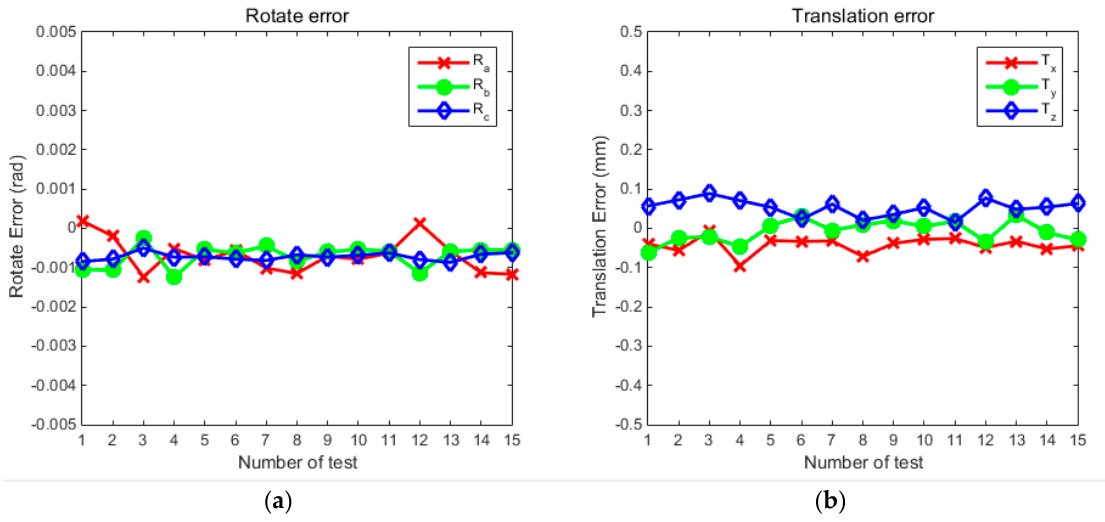
Figure 6. The error curves of the calibration results for the two-camera experiment. ( a ) the three rotation angle error curves; ( b ) the translation error curves.